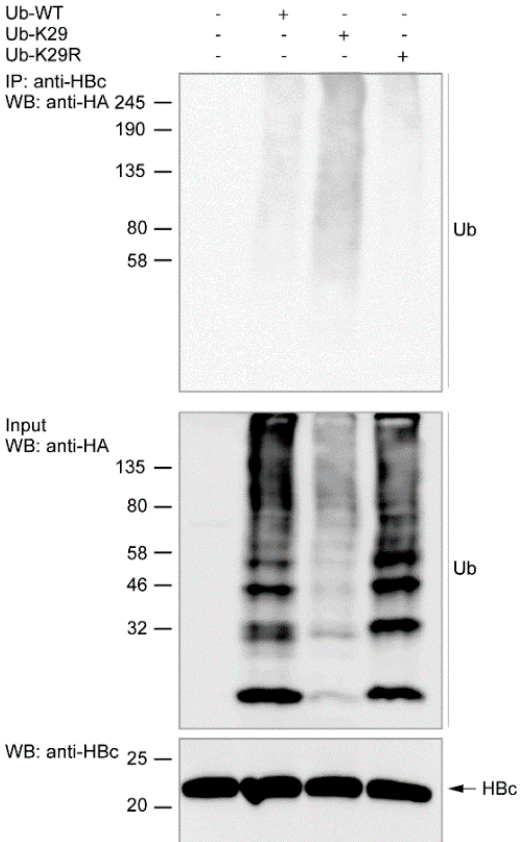
Figure 6. Endogenous HBc is polyubiquitinated within the HepG2-hNTCP cells. Western blots of co-immunoprecipitated complexes of HBV-infected HepG2-hNTCP cells transiently transfected with an empty vector, or HA-tagged Ub-WT, Ub-K29, or Ub-K29R with endogenous HBc and exogenous ubiquitin variants expressed in the cells (WB: Input of 10 µg of total protein/lane). Co-immunoprecipitation reactions were performed using Protein A magnetic beads equilibrated with anti-HBc antibody (from Gilead Sciences).